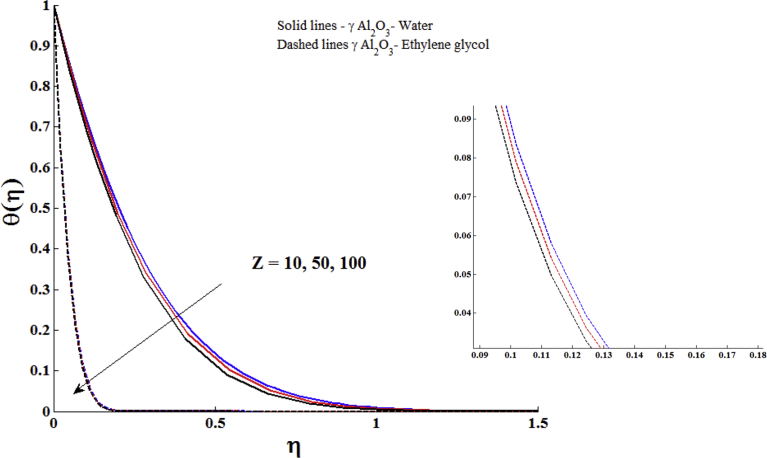
Impact of modified Hartmann number on temperature profile with ϕ = 0.1, Pr = 6.96 (γ Al2O3- Water) and Pr = 204 (γ Al2O3- Ethylene glycol).